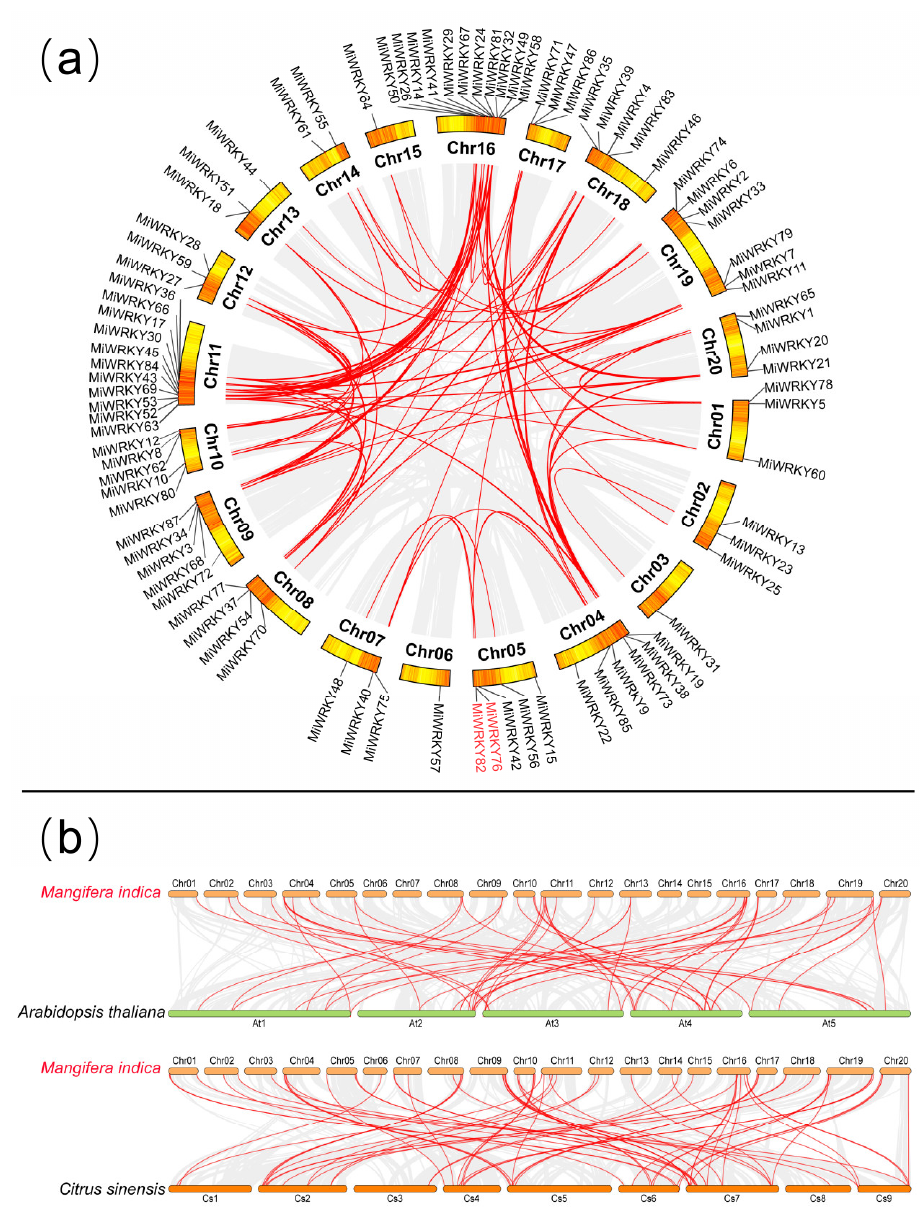
Figure 4. The syntenic relationship of WRKY genes. ( a ) The interchromosomal relationship of the MiWRKY genes in the mango. Red lines indicate segmental duplicates of MiWRKY genes. MiWRKY76 and MiWRKY82 marked in red font are defined as tandem duplication events. ( b ) Collinearity analysis of WRKY genes among Mangifera indica, Arabidopsis thaliana, and Citrus sinensis . Red lines highlighted syntenic WRKY gene pairs, gray lines indicate collinear blocks within the three species.